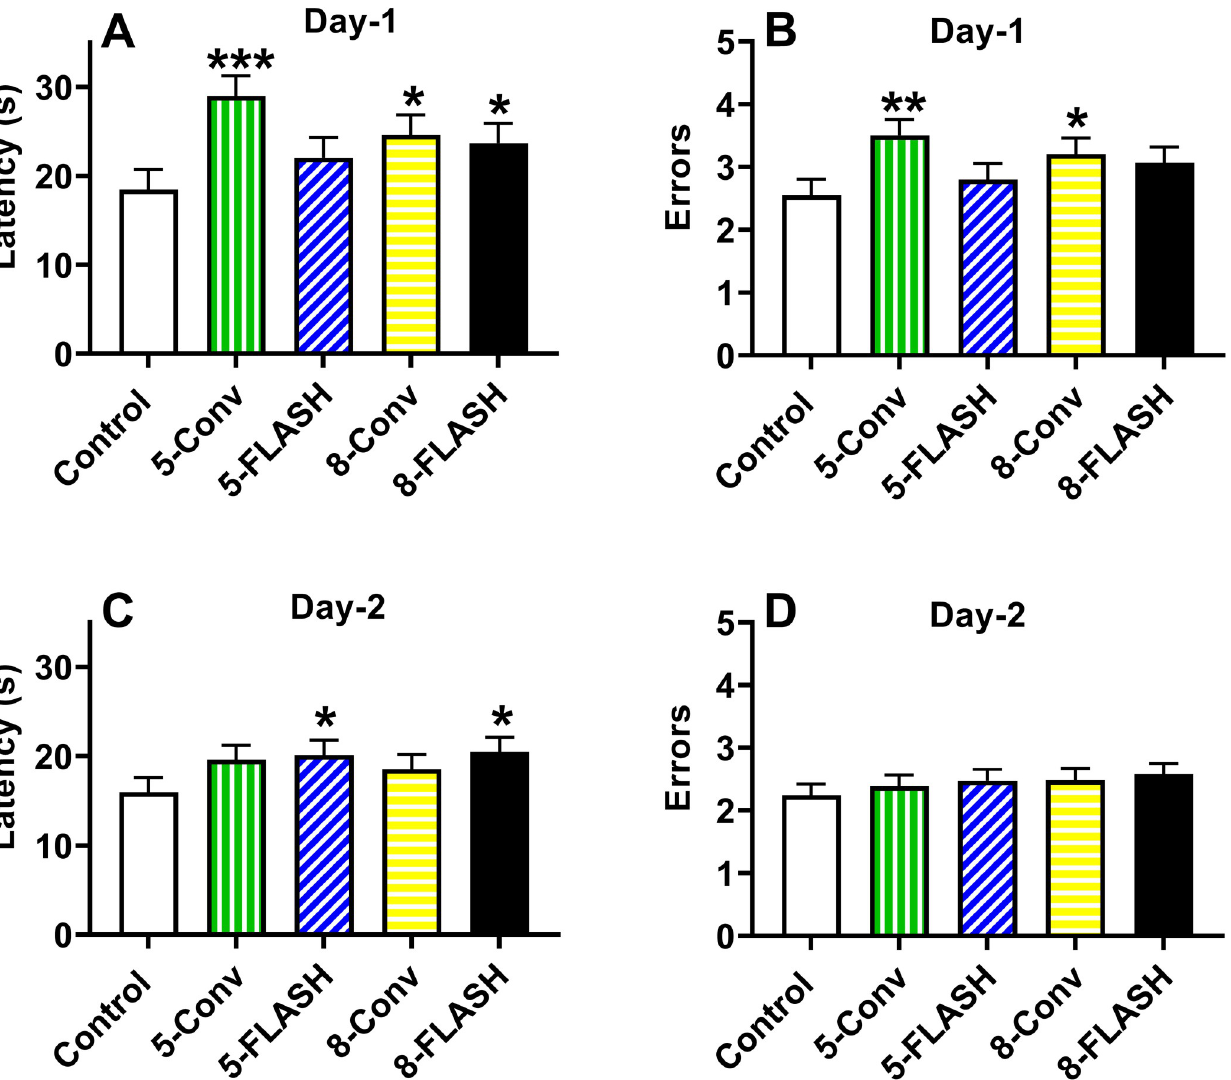
Fig 6. The radial water maze latency [s (mean ± SEM)] and number of errors (mean ± SEM) of proton irradiated and control rats on Day 1 and Day 2. A. The overall effect on latency in the radial water maze on Day 1. With the exception of the 5-FLASH group, the irradiated groups took longer to locate the platform. B. The overall effect on mean errors per trial in the radial water maze on Day 1. The 5-Conv and 8-Conv group made more errors compared with controls, while there was no difference for the FLASH groups and controls. N = 19/sex/exposure except control male and 5-FLASH male = 18. C. The overall effect on latency in the radial water maze on Day 2. The 5-FLASH and 8-FLASH groups took longer to locate the platform compared with controls. D . The overall effect on mean errors in the radial water maze on Day 2. There were no differences between irradiated groups and controls. There was an interaction of exposure × sex × trial where males in the 5-FLASH and 8-Conv groups made more errors on trial-7 only (not shown). N = 19/sex/exposure except control male, 5-FLASH male, and 8-Conv females = 18. One 8-Conv female was inadvertently missed. � p < 0.05, �� p < 0.01, and ��� p < 0.001 compared with